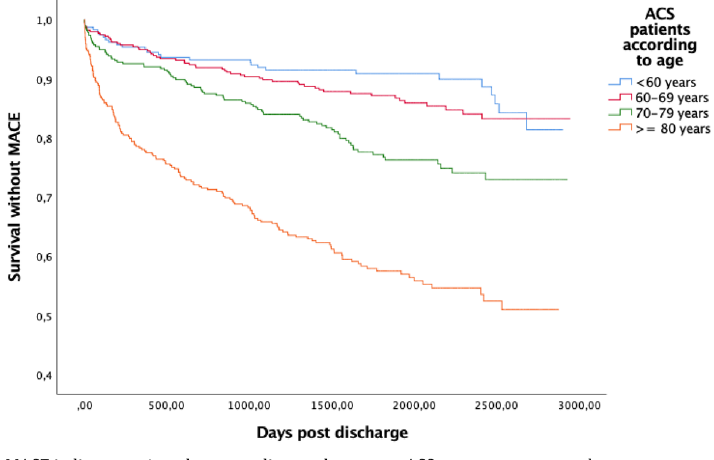
Figure 6. Cumulative Kaplan–Meier estimate of survival without MACE according to age groups among 1379 patients discharged after hospitalization for ACS between 1 Jan 2010 and 31 Dec 2014.